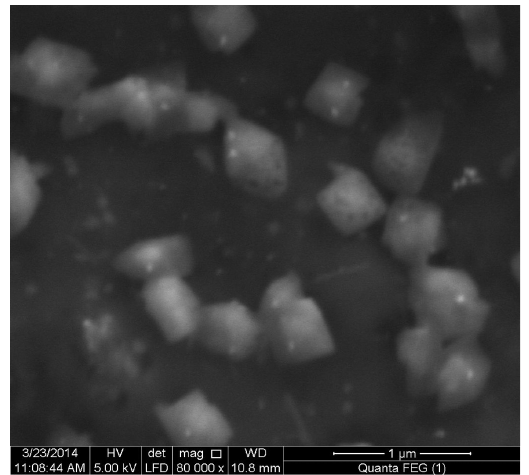
Figure 6 Scanning electron microscopy (SEM) of Ag-polyvinyl alcohol (PVA) bulk layers of the nanocomposite films.